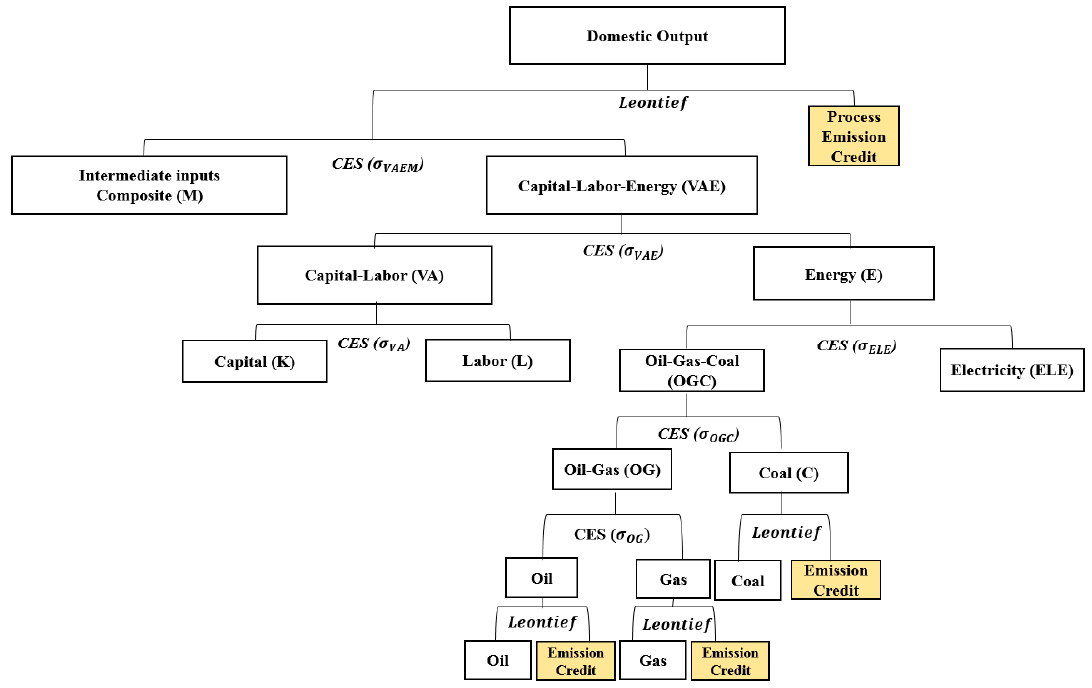
Figure 1. Production composite structure of the computable general equilibrium model in this study.